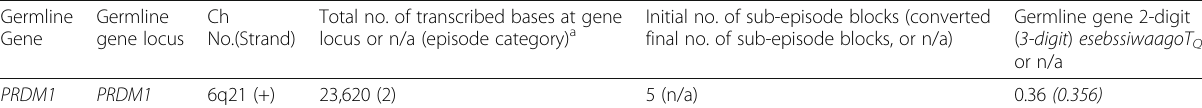
Table 3 Chromosome 6 (+) strand chromatin B-cell transcription factor adapter gene, PRDM1 , esebssiwaagoT Q for pressuromodulation mapping of B-cell differentiation Germline Germline Ch Total no. of transcribed bases at gene Gene gene locus No.(Strand) locus or n/a (episode category) a